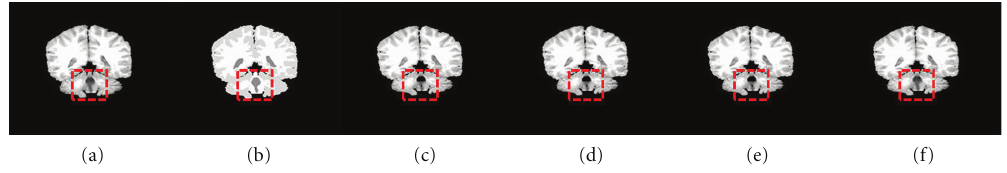
Figure 2: Comparison of the segmentation results on a simulated brain MR image. (a) original T1-weighted image, (b) manual class labeling of gray matter (GM) and white matter (WM) slice regions; results obtained with (c) FCM, (d) MSFCM, (e) FCMT, (f) SFCM, and (g) the proposed approach.